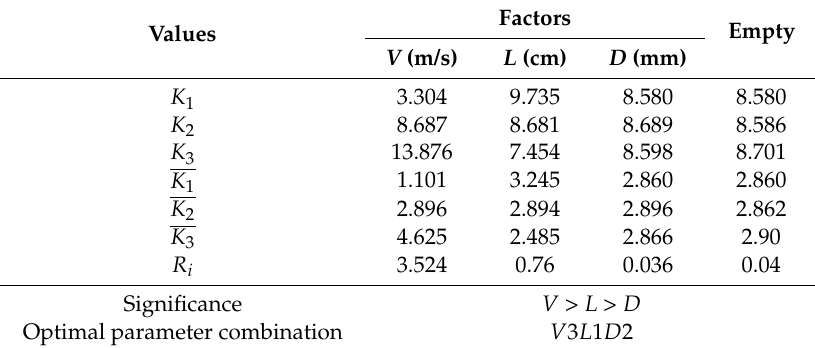
Table 4. Range analysis of the erosion depth.